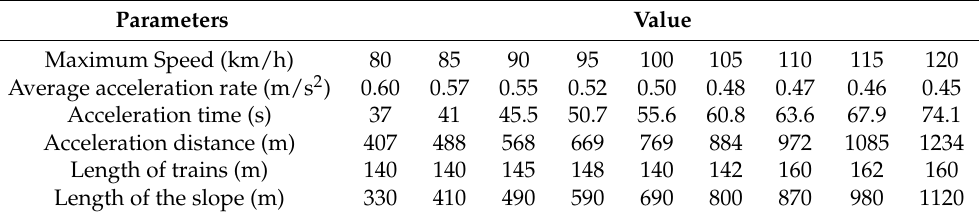
Table 9. Length of the energy-efficient slopes with different train